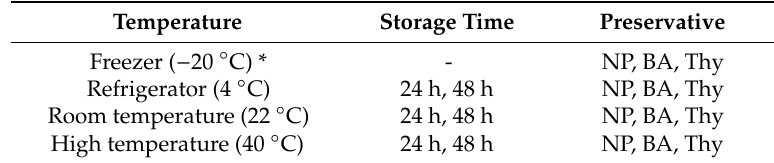
Table 1. Urine storage conditions under investigation in both para-aminobenzoic acid (PABA) and No PABA